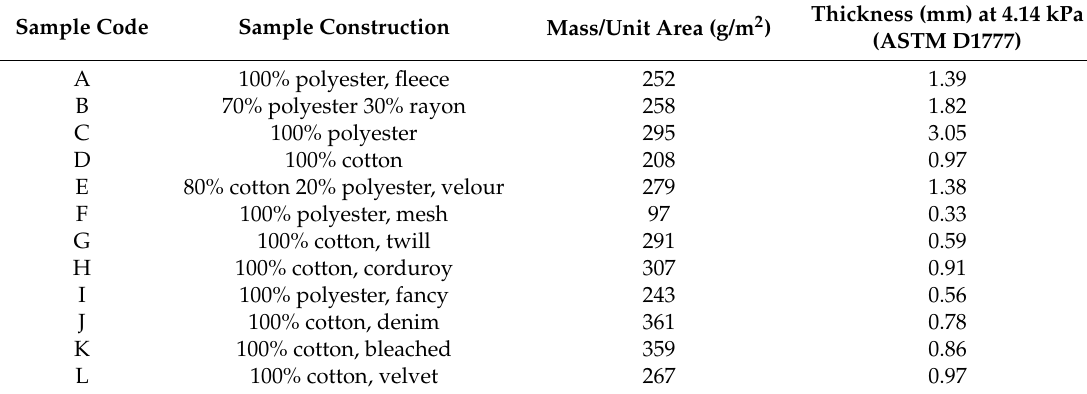
Table 2. Sample structural parameters.